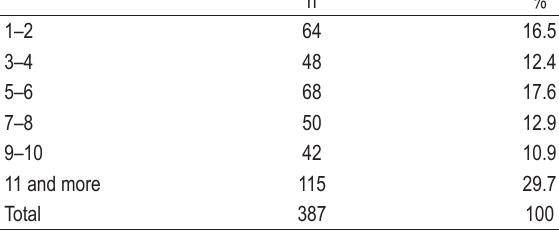
TABLE 2. Number of sexual intercourses per